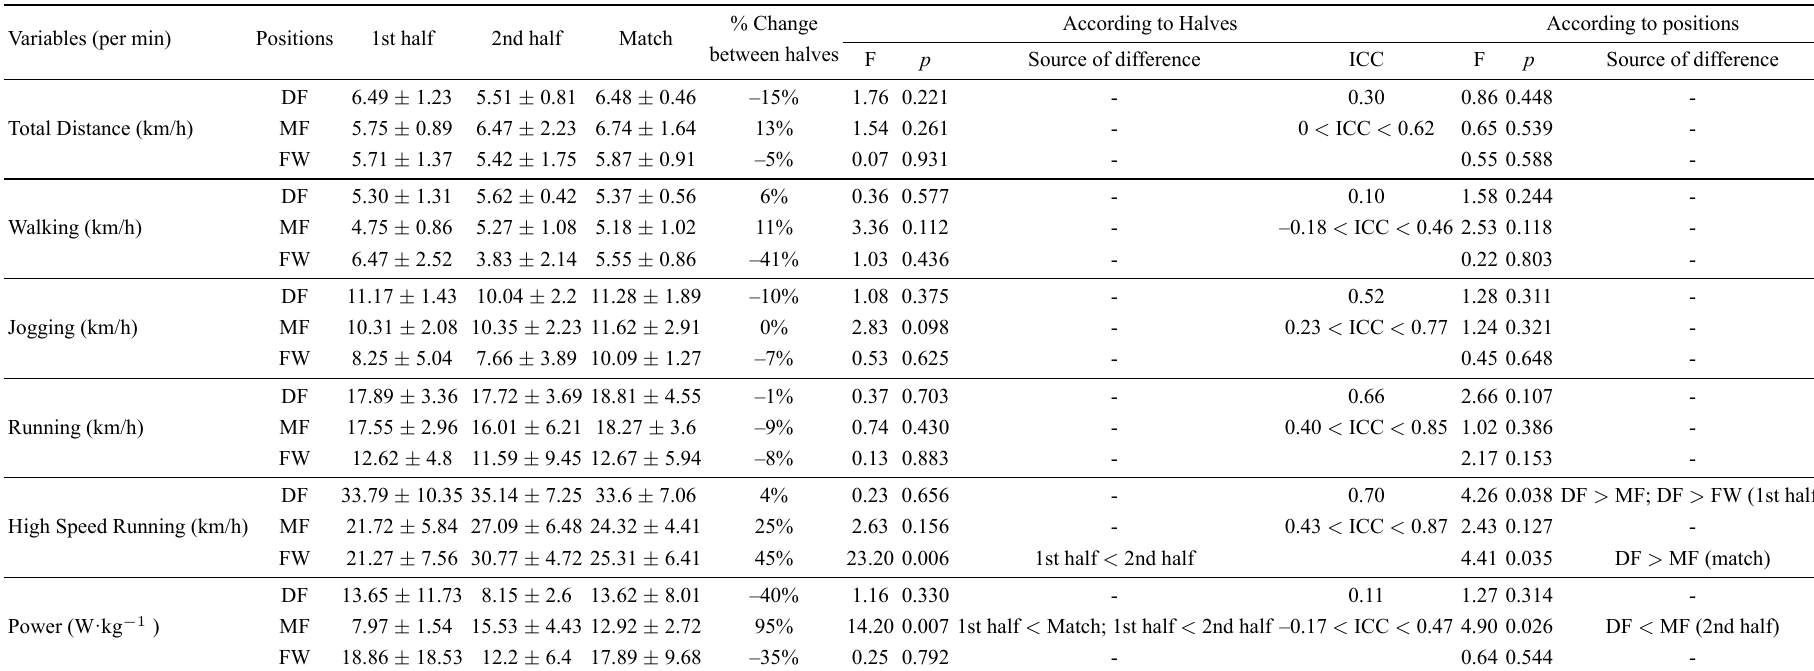
Table 2. Coefficient of Variation of Match Activities according to Playing Positions, and Match